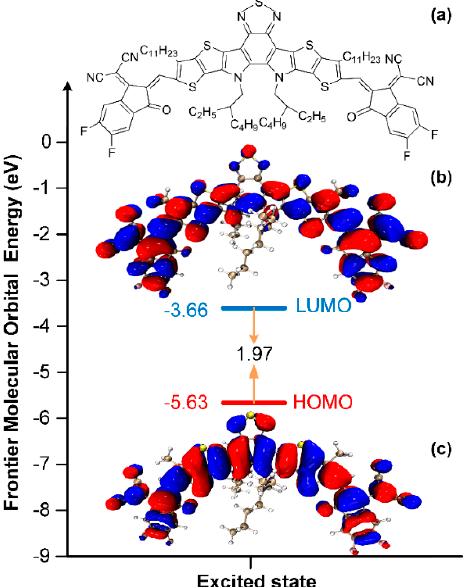
Figure 1. ( a ) Molecular structure and electron density contours of ( b ) LUMO level and ( c ) HOMO level for Y6 with dielectric constant of 4.7113 (Chloroform solution) by TD-DFT with B3LYP / Def2-TZVPP. The isosurface value was set at 0.01 a.u.